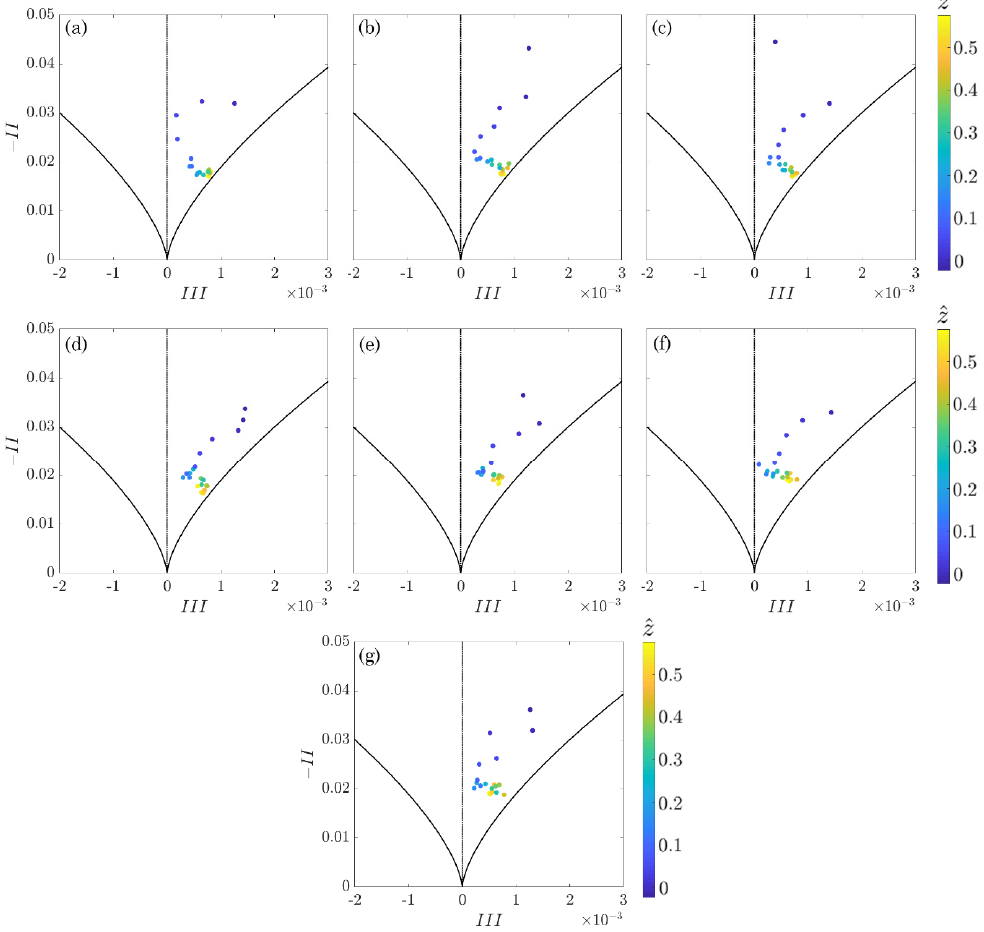
Figure 8. AIMs of Run 2 at ( a ) x / L s = 0, ( b ) x / L s = 0.17, ( c ) x / L s = 0.33, ( d ) x / L s = 0.50 (at the vegetation stem axis), ( e ) x / L s = 0.67, ( f ) x / L s = 0.83, ( g ) x / L s = 1.00.